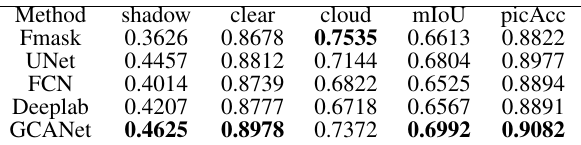
Figure 5. Three cloud detection examples of the SPARCS. Column (a) is the original Landsat-8 images; column (b) is the ground-truth labels; column (c)(d)(e)(f)(g) are the results of Fmask, FCN, Deeplab, UNet and the proposed GCANet respectively. Table 2. Results of the second group of experiments. The 2-4 columns denote the IoU of each class respectively.